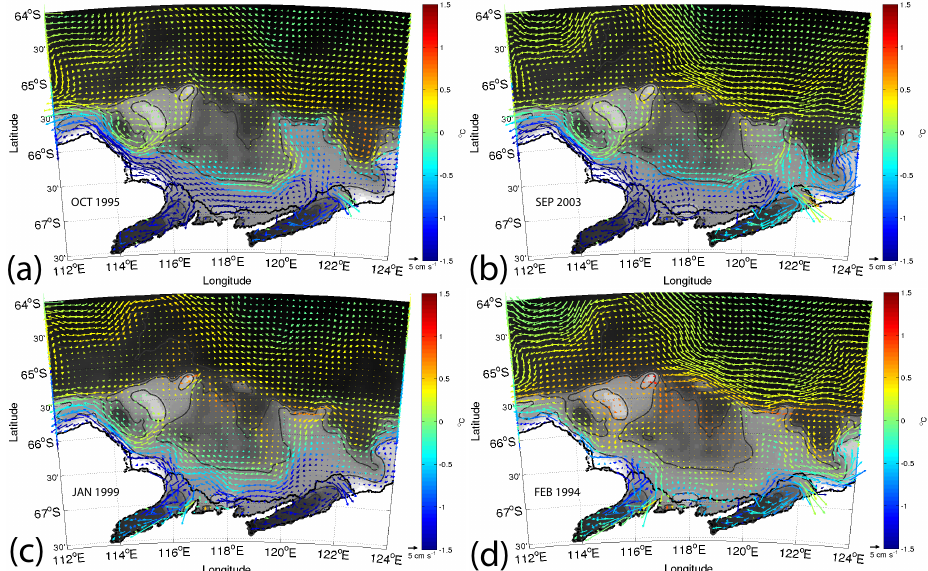
Fig. 5. Simulated column-averaged currents (excluding the surface layer), where the vectors are coloured for mean column temperature, and scaled according to the reference vector. (a) October 1995. Strong winds drive polynya activity and the ACoC, inhibiting heat flow to the Totten ice shelf. There is no flow over the Dalton rise. (b) September 2003. Strong polynya activity increases HSSW production, preventing warm water entry to the Totten ice shelf cavity and decreasing melt rates. Flow over the Dalton rise supplies heat for melting to the Dalton ice shelf. (c) January 1999. Polynya activity and ACoC are weak, allowing heat supply to cause melting of the Totten ice shelf. There is no flow over the Dalton rise, so Dalton ice shelf melt rates drop. (d) February 1994. Polynya activity and ACoC are very weak, allowing warm inflow to Totten ice shelf. Flow over the Dalton rise can increase melting of Dalton ice shelf.